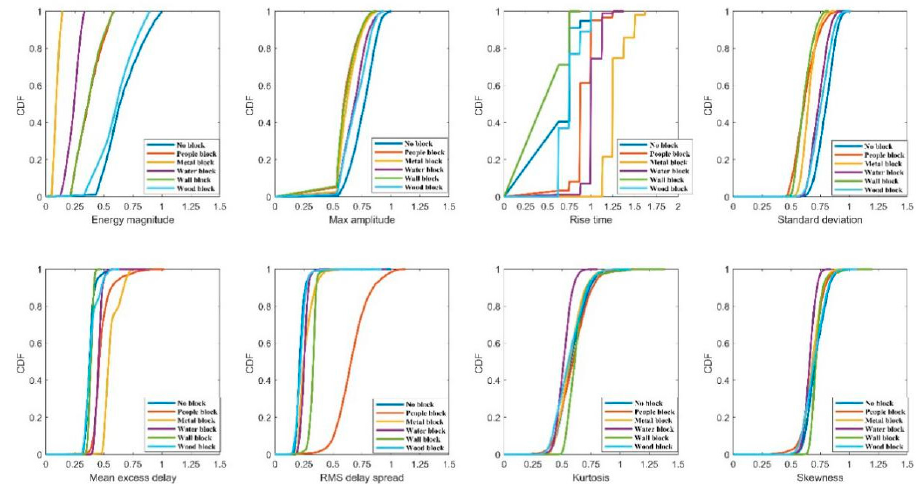
Figure 4. The cumulative distribution of features of di ff erent blocking classes at 30 CIR signal points.